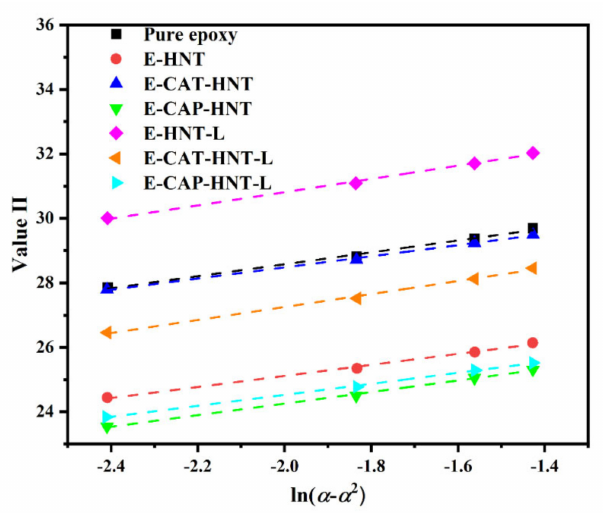
Figure 8. Plots of Value II calculated for prepared samples under heating rate of 5 ◦